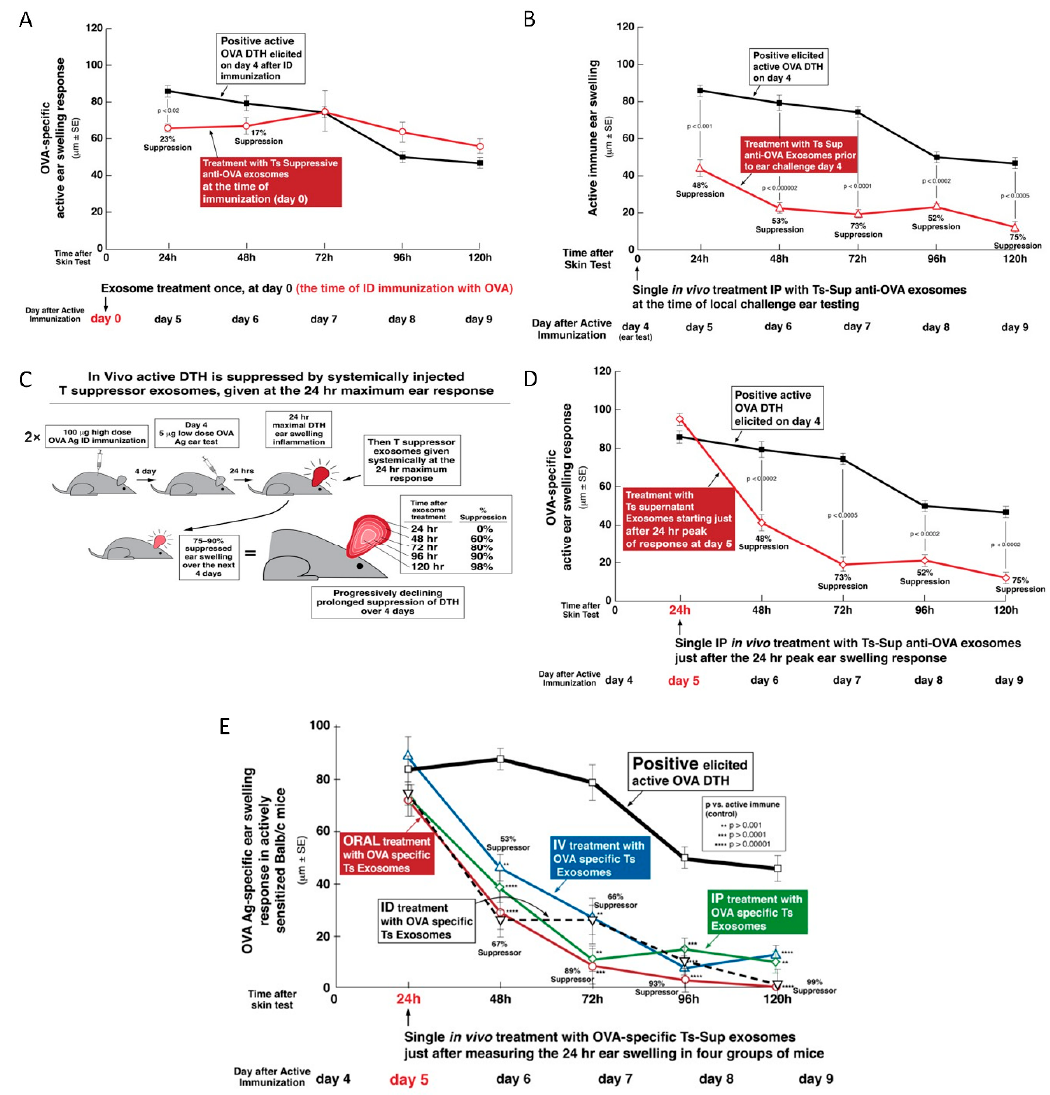
Figure 3. In vivo treatment of active OVA DTH with a systemically administered, single dose of suppressor T cell-derived exosomes, given at various times, and by various routes, including oral and intradermal (ID), with assessment of their Ag-specificity. ( A ) In vivo treatment of OVA-induced, active DTH with OVA-specific, suppressive exosomes, administered IP at the time of immunization on day 0, were not suppressive of subsequently elicited 24-h DTH ear swelling responses measured over five days. ( B ) In vivo treatment of OVA-induced, active DTH with OVA-specific, suppressive exosomes, administered IP just before elicitation of the DTH response by ear challenge on day 4, were strongly suppressive (48–75% suppression over the subsequent five days). ( C ) Protocol: In vivo treatment of active OVA DTH with systemically administered suppressor T cell exosomes, given just after measurement of the 24-h maximum ear swelling response. ( D ) In vivo intraperitoneal (IP) treatment of OVA active DTH with OVA-specific suppressor T cell-derived exosomes administered at the 24-h peak of response, were strongly suppressive (48–75% suppression over the subsequent four days). ( E ) Comparing intravenous (IV), IP, ID, and oral treatment of actively OVA DTH immunized mice with OVA-specific suppressor T cell-derived exosomes; starting at the 24-h peak of response, and measured over the subsequent four days; all significantly inhibited DTH ear swelling; especially oral treatment (the red line). Results are shown as delta ± standard error (SE), one-way ANOVA with post hoc RIR Tukey test. n = 5 mice in each